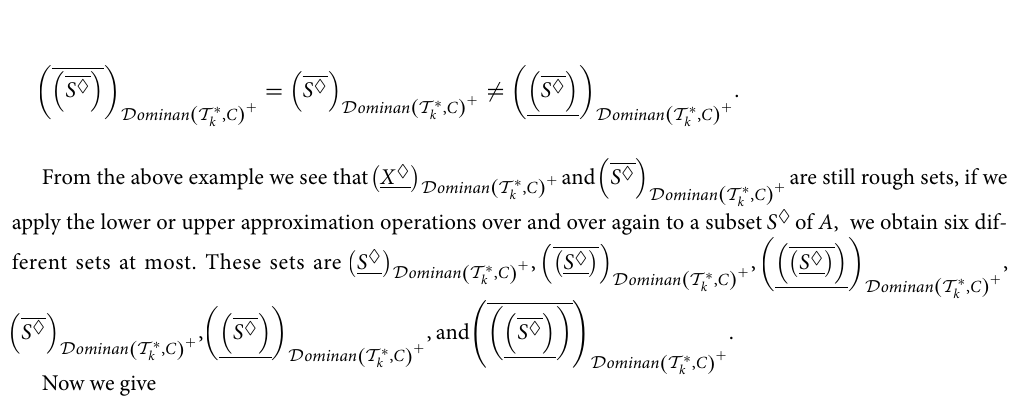
C ) and Dominated classes 1 ,